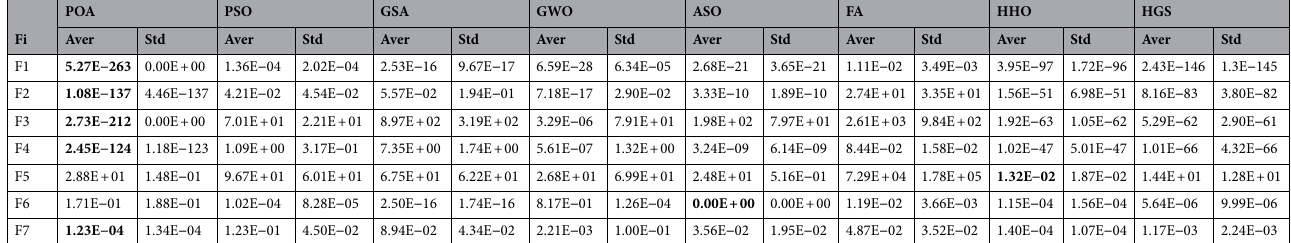
Table 2. Results of unimodal benchmark functions. Significant values are in bold.